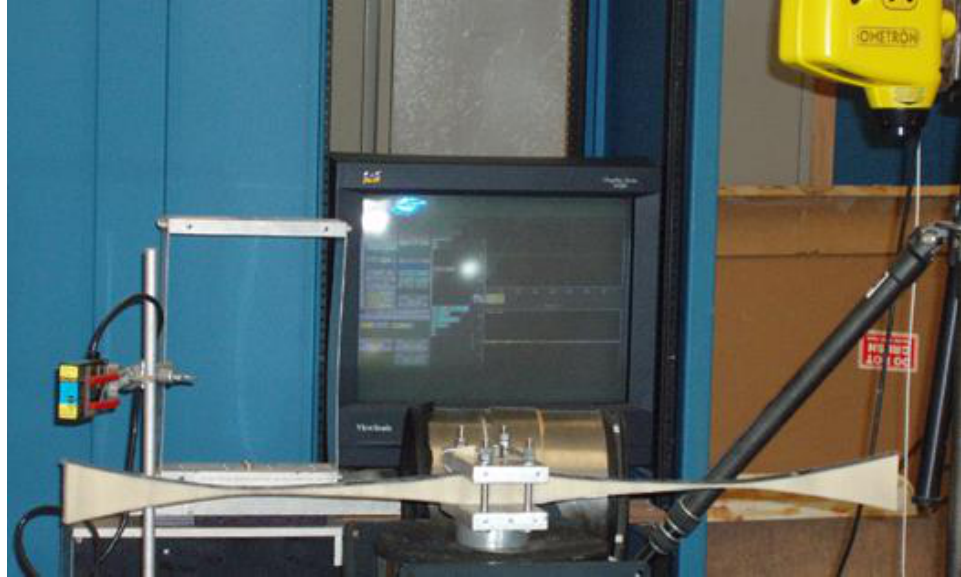
Figure 13. Experimental setup for composite specimen vibration using the double cantilever technique.